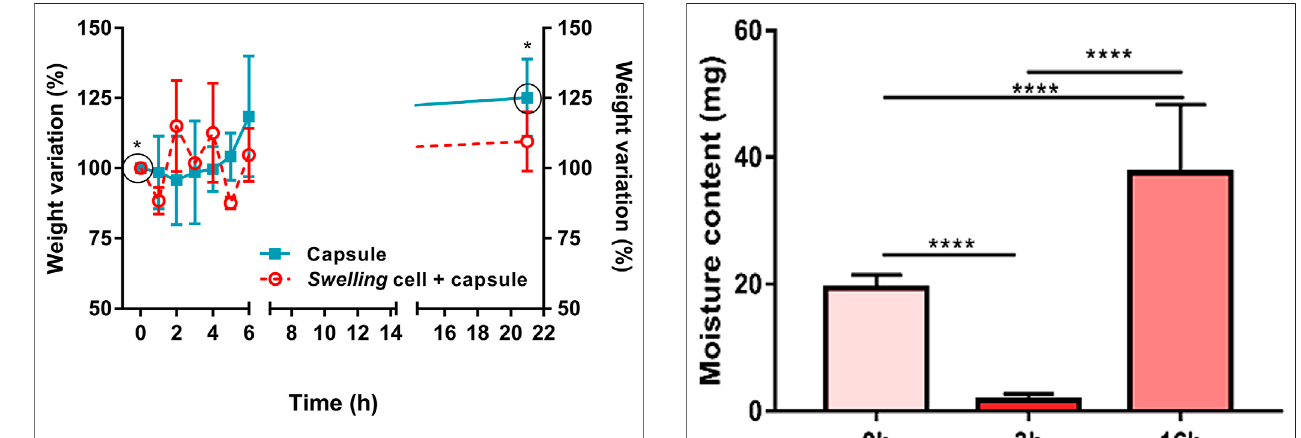
FIGURE 4 | Swelling behavior of pristine alginate capsules ( n (cid:2) 10) and capsules with MSCs ( n (cid:2) 10). Although capsules with MSCs showed less stability in mass through time, there was a signi fi cant increase in mass of the group of capsules alone at 21 h compared to the initial time point (* indicates p < 0.05).